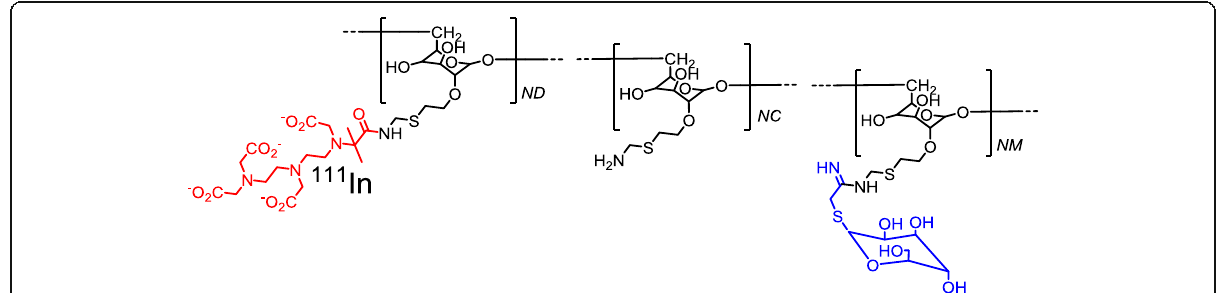
Fig. 1 Chemical structure of tilmanocept. It is composed of a dextran backbone ( black ) and multiple units of D -mannose ( blue ) and DTPA (red) attached to the backbone. The D -mannose units are the receptor recognizing moieties, and the DTPA units are used for 111 In